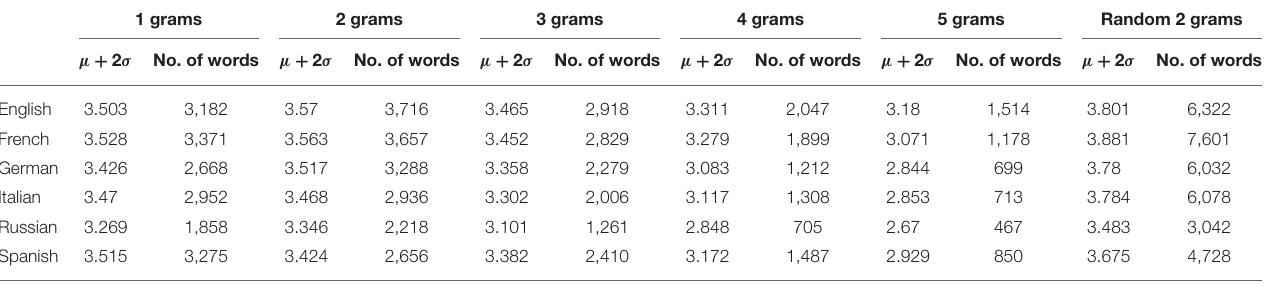
TABLE 4 | Language core parameters. Upper bound rank log 10 k Equation (1), as well as the number of words included in the N -grams within the core in the year